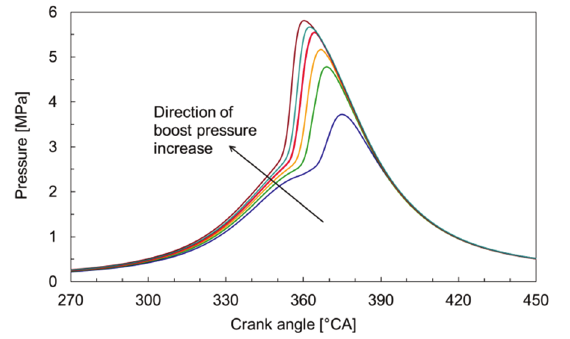
Fig. 2. In-cylinder pressure at IMEP ≈ 0.58 MPa for boost pressure be- tween 0.11 MPa and 0.14 MPa